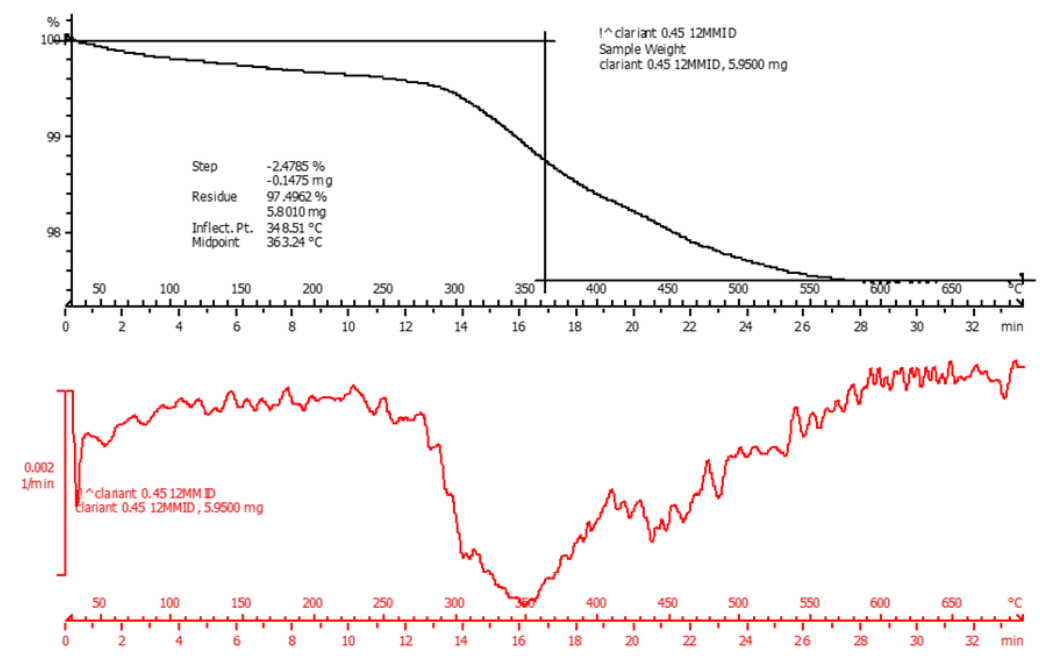
Figure A3. TGA graph for R3.